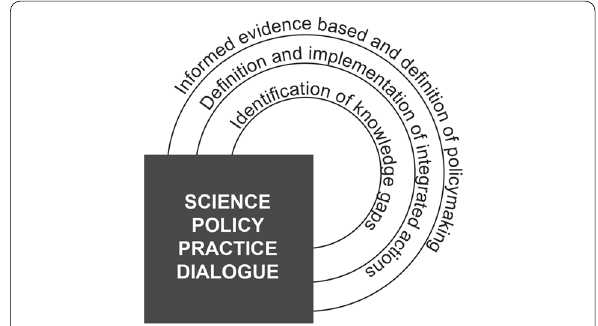
Fig. 2 The science-policy-practice dialogue for urban resilience. Source: Authors’